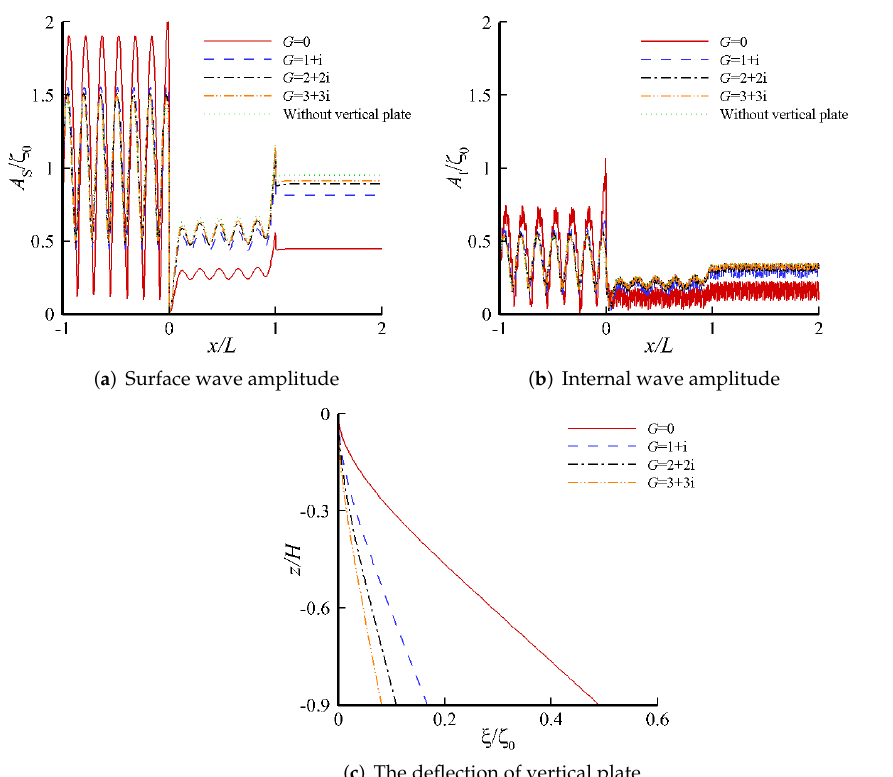
Figure 13. Wave amplitudes A S ( x ) and deflection of vertical plate ξ ( z ) for the different G .